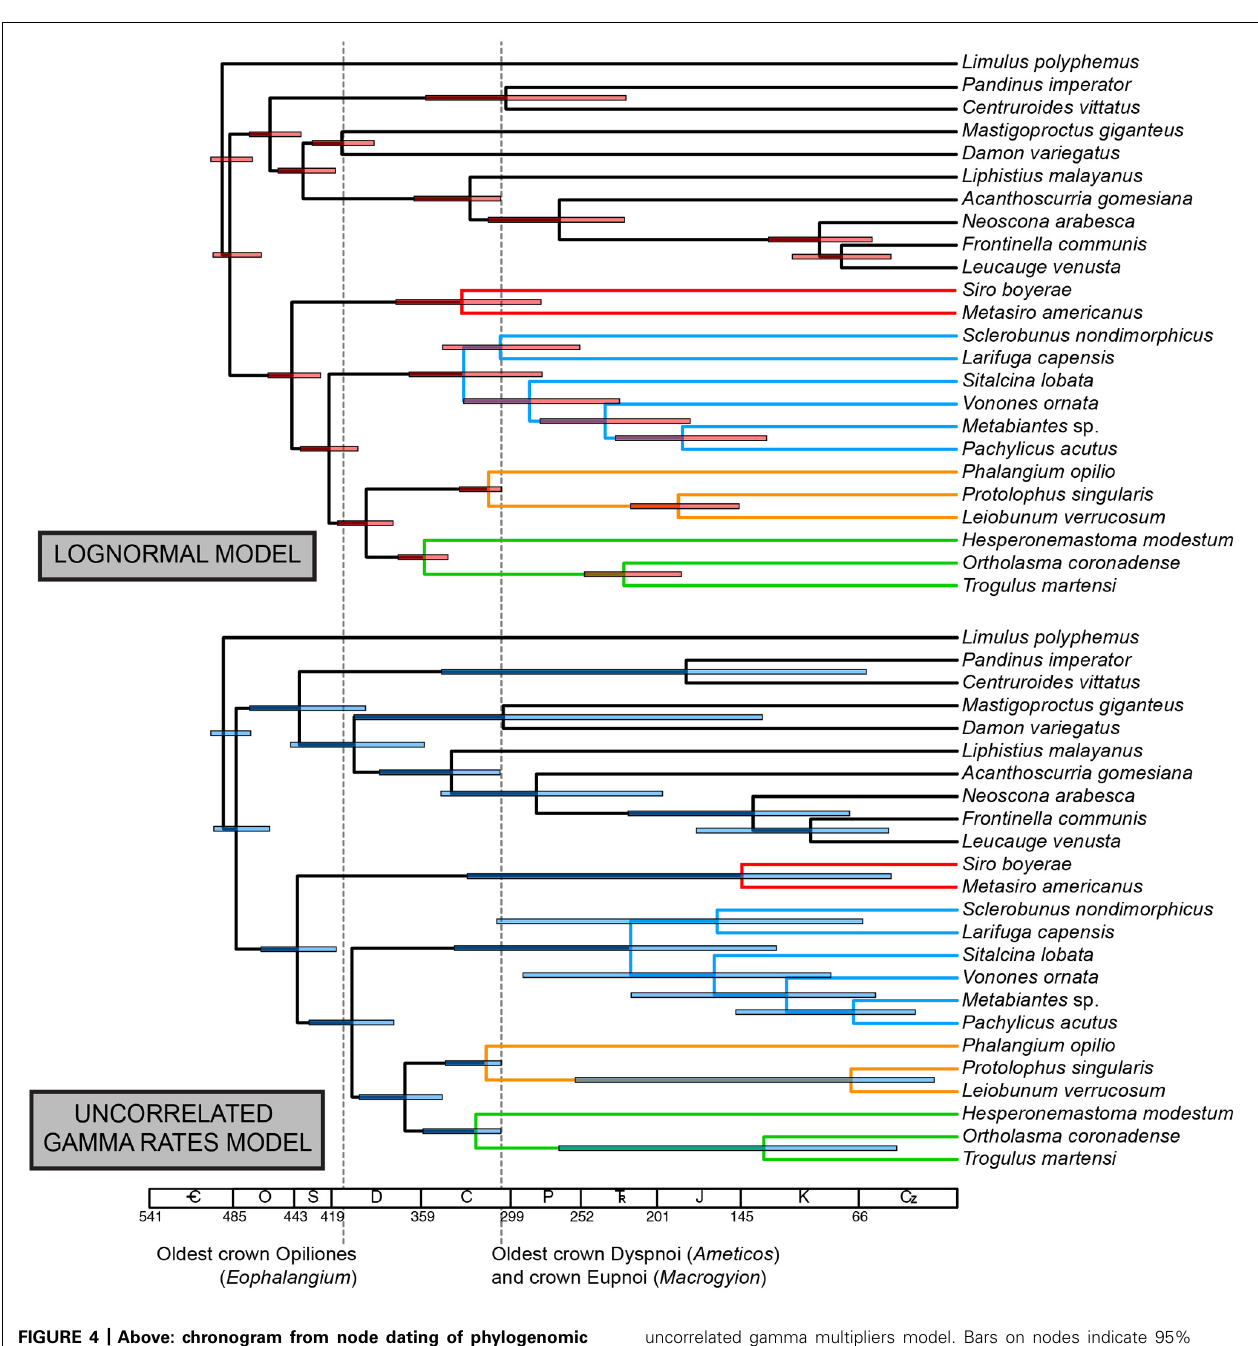
uncorrelated gamma multipliers model. Bars on nodes indicate 95% highest posterior density intervals. Colors in branches correspond to suborders, as in Figure 2